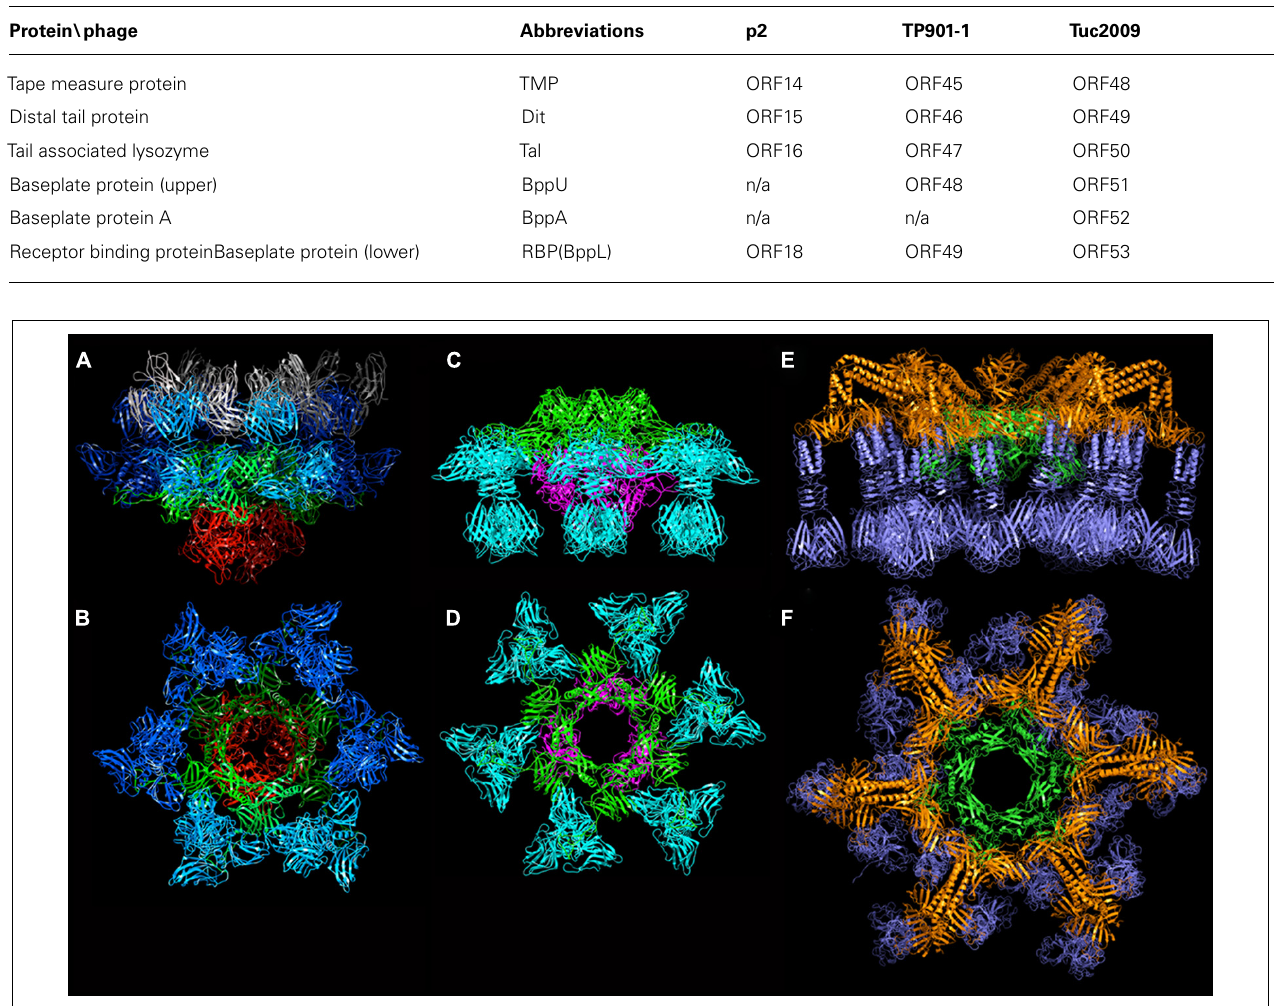
FIGURE 6 |The crystal structures of the baseplates of phages p2 and TP901-1. (A) Side-view of the phage p2 baseplate rest form in complex with the llama VHH5 (ORF15/Dit, green; ORF16/Tal, red; ORF18/RBP, blue; VHH5, gray). (B) Top-view of the phage p2 baseplate rest form (same colors are in A , but the VHH5 has been removed from the view). (C) Side-view of the